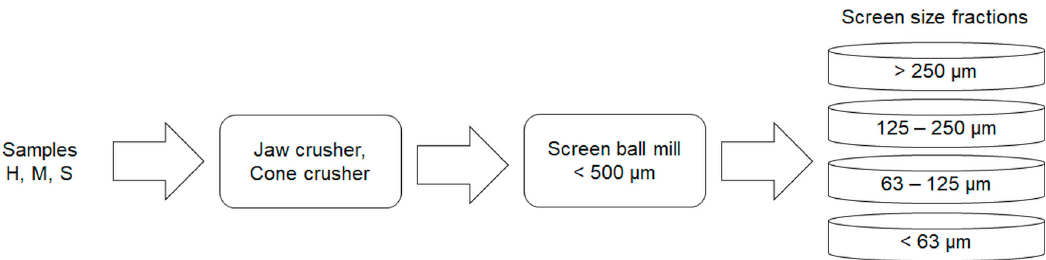
Figure 6. Preparation of samples H, M, and S for analyses via SEM-based image analyses; after a sequence of jaw and cone crushing, the material is milled down to an upper particle size of 500 µm. The material is then screened into four size fractions.